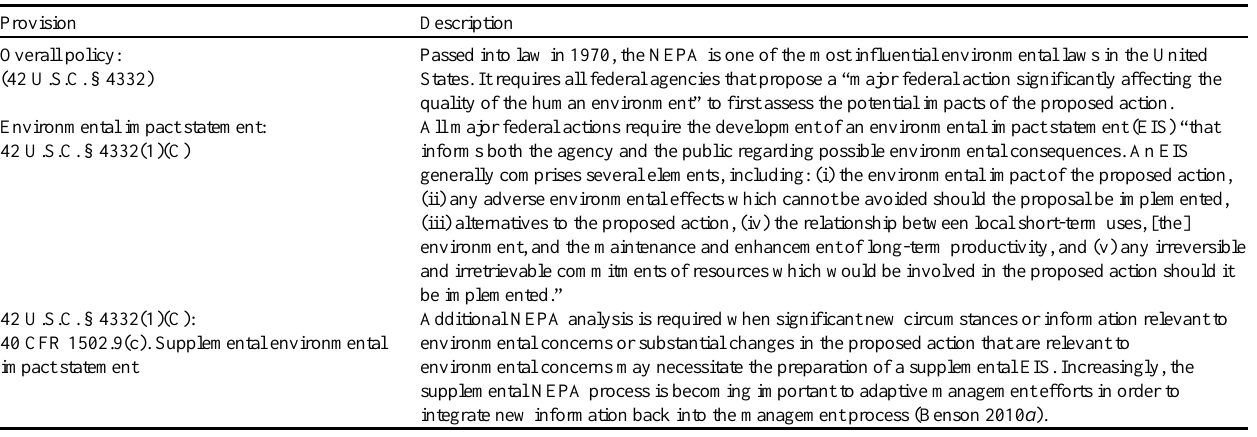
Table 3. Summary of the National Environmental Policy Act (NEPA) and its key provisions.